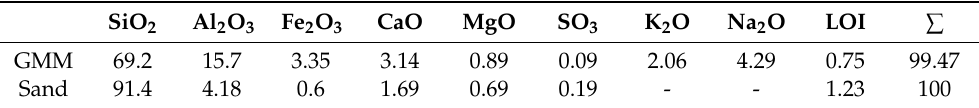
Table 2. Chemical composition of granite mineral modifier and sand